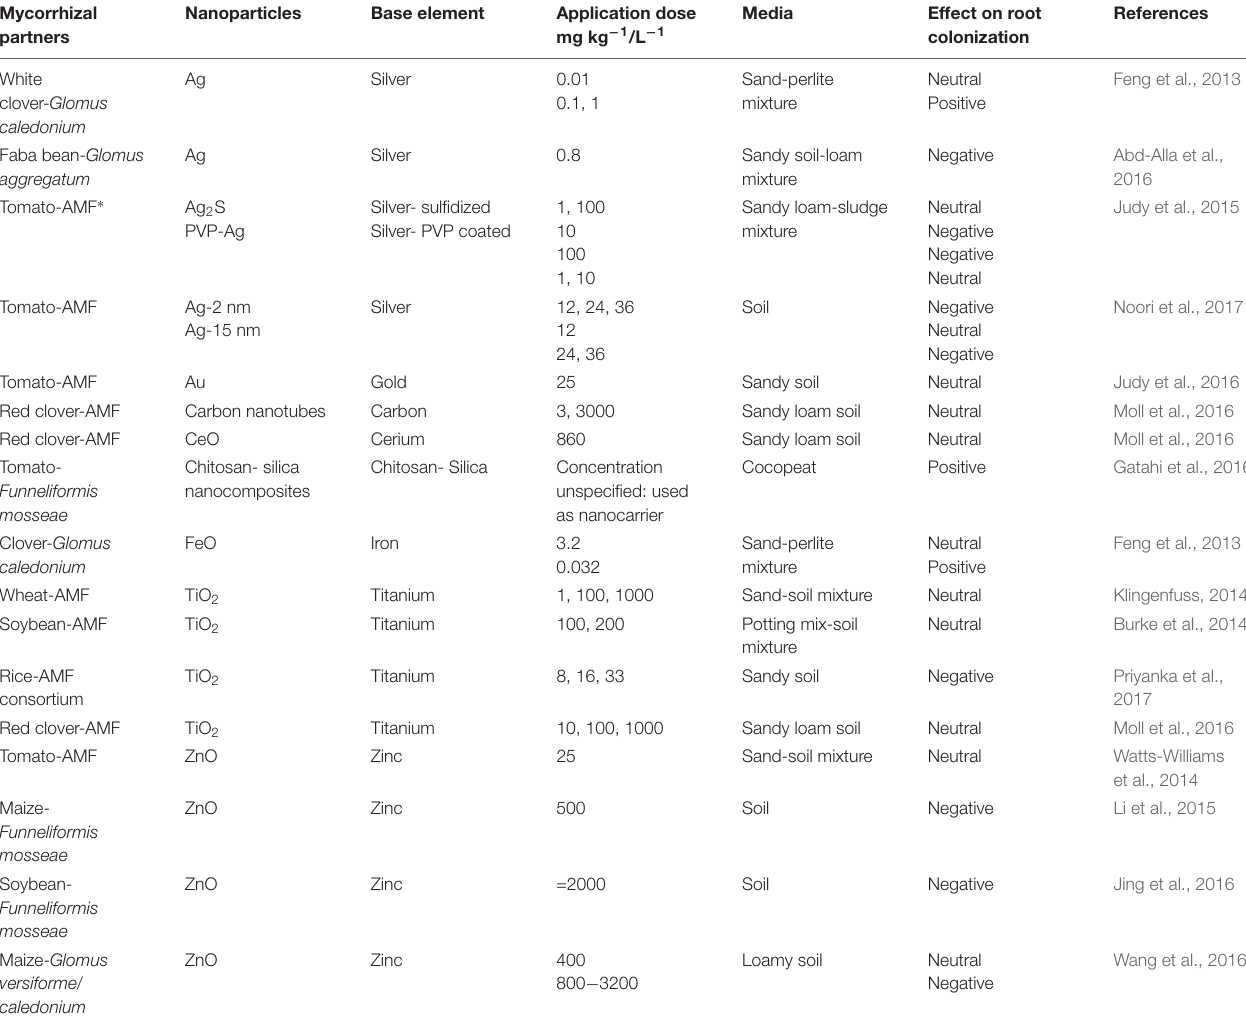
TABLE 2 | Effects of different nanoparticles on development of mycorrhizal